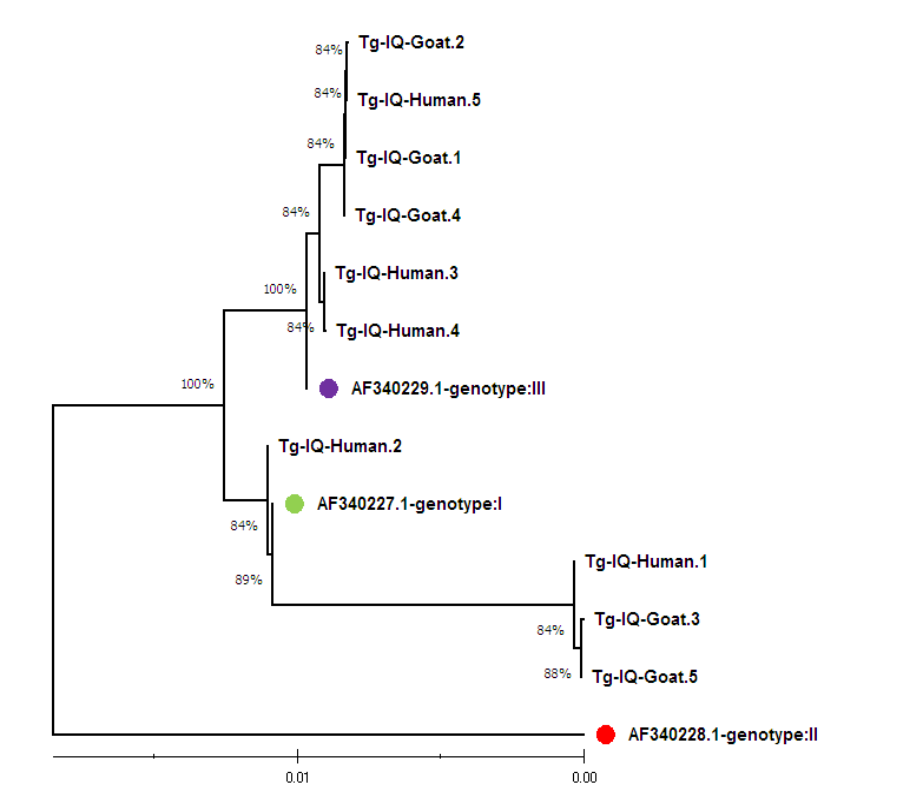
Figure 3. Phylogenetic tree analysis based on the complete sequence of surface antigen (SAG3) gene in T. gondii of local goats and human isolates used for genotyping